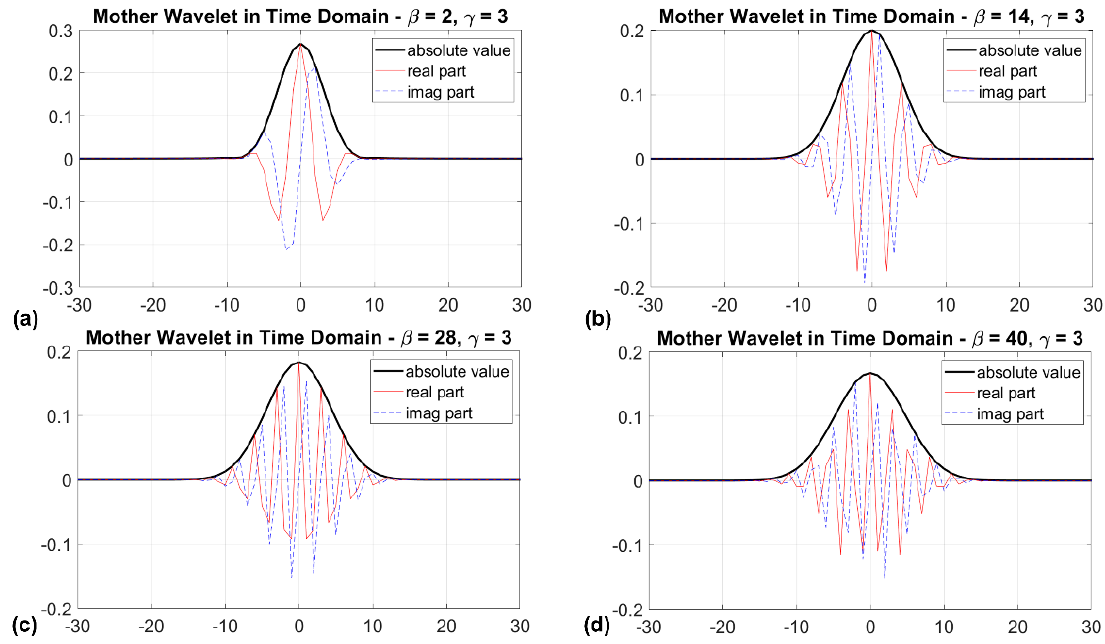
Figure 6. Mother wavelets (in the time domain) corresponding to the results shown in Figure 4 ( 𝛾 = 3 and 𝛽 equal to ( a ) 2, ( b ) 14 , ( c ) 28 , and ( d ) 40).